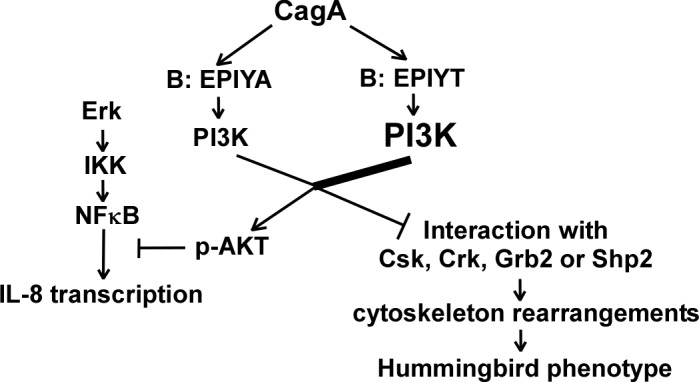
Proposed model showing that CagA may regulate activation of the PI3-kinase/AKT pathway through B-domain alternative TPM sequences.CagA proteins possessing a B-domain TPM with an EPIYT sequence may have more chance of tyrosine phosphorylation by host kinases. The different phosphorylation levels regulate CagA-tyrosine phosphorylation-dependent PI3-kinase interaction and AKT activation. Activated AKT further regulates AGS cell cytoskeleton rearrangements to affect CagA-induced hummingbird cell formation and inflammatory cytokine IL-8 secretion.